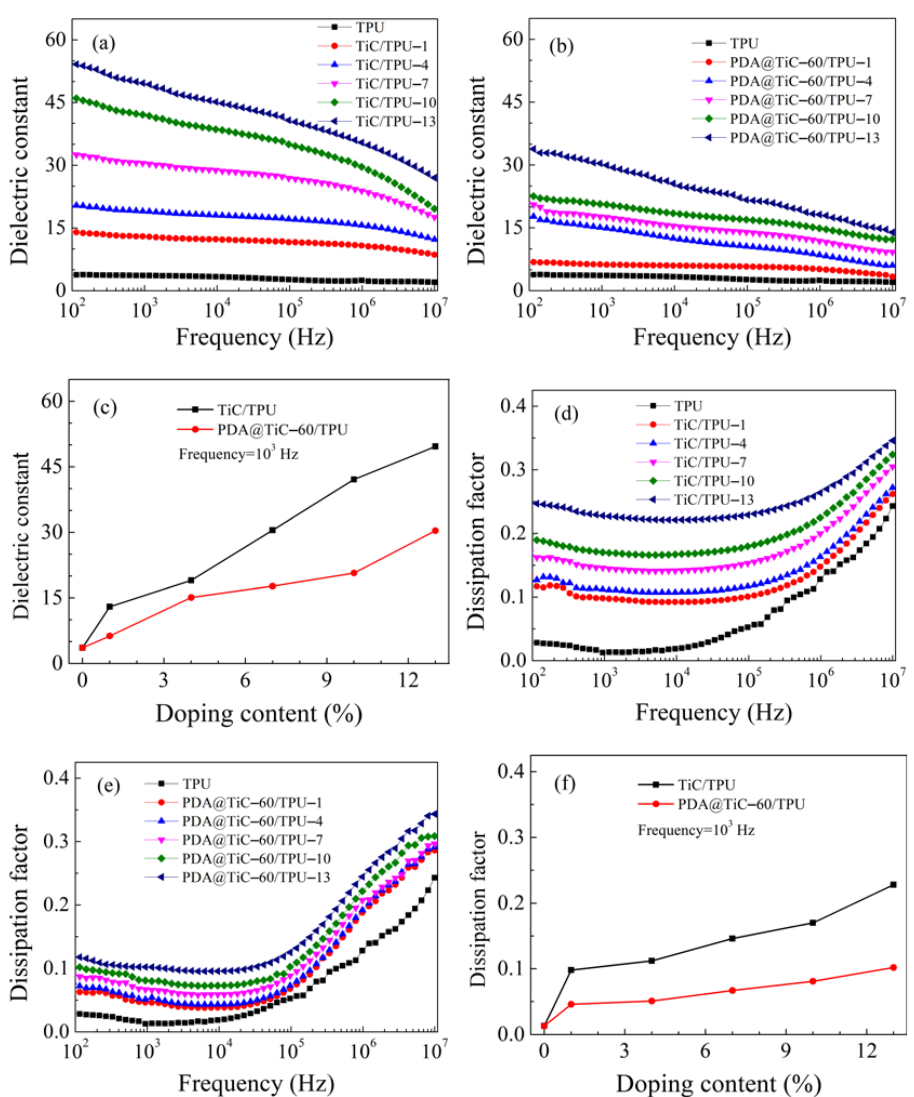
Figure 6. Frequency dependence on the dielectric constant of TiC/TPU ( a ), PDA@TiC − 60/TPU ( b ); dielectric constant of TiC/TPU and PDA@TiC − 60/TPU with different filler content at 10 3 Hz ( c ); frequency dependence on dissipation factor of TiC/TPU ( d ), PDA@TiC − 60/TPU ( e ) and dissipation factor of TiC/TPU and PDA@TiC − 60/TPU with different filler content at 10 3 Hz ( f ).